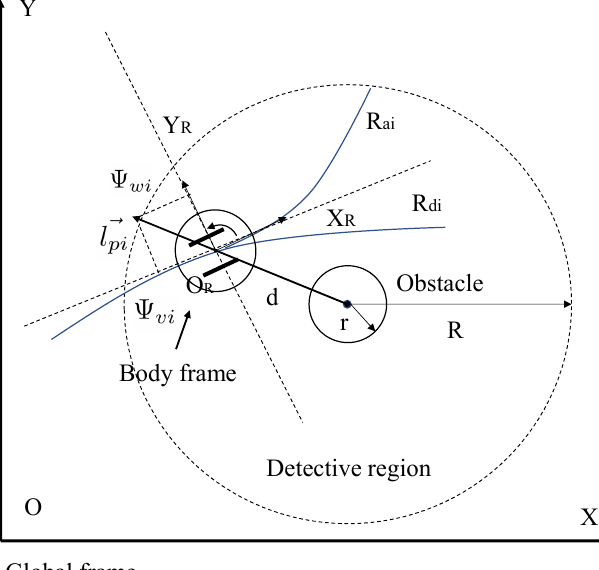
Figure 4. Trajectory adjustment for collision avoidance via the potential function